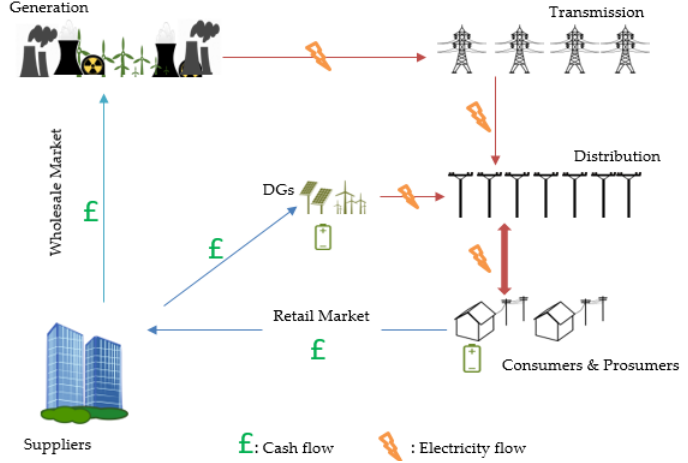
Figure 3. Example of a liberalised electricity market structure.